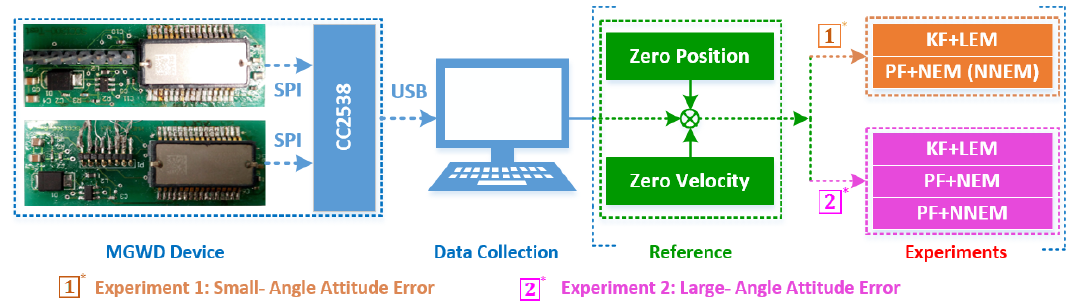
Figure 4. Process of data collection and contents of experiments. The MEMS sensors sense the angular rate and specific force of the drill bit and then transfer the data to the computer through a USB interface for evaluation of navigation solutions. The proposed algorithm would be verified by two groups of designed experiments with the reference of zero velocity and zero position. The design rule of experiments is based on the initial attitude error.